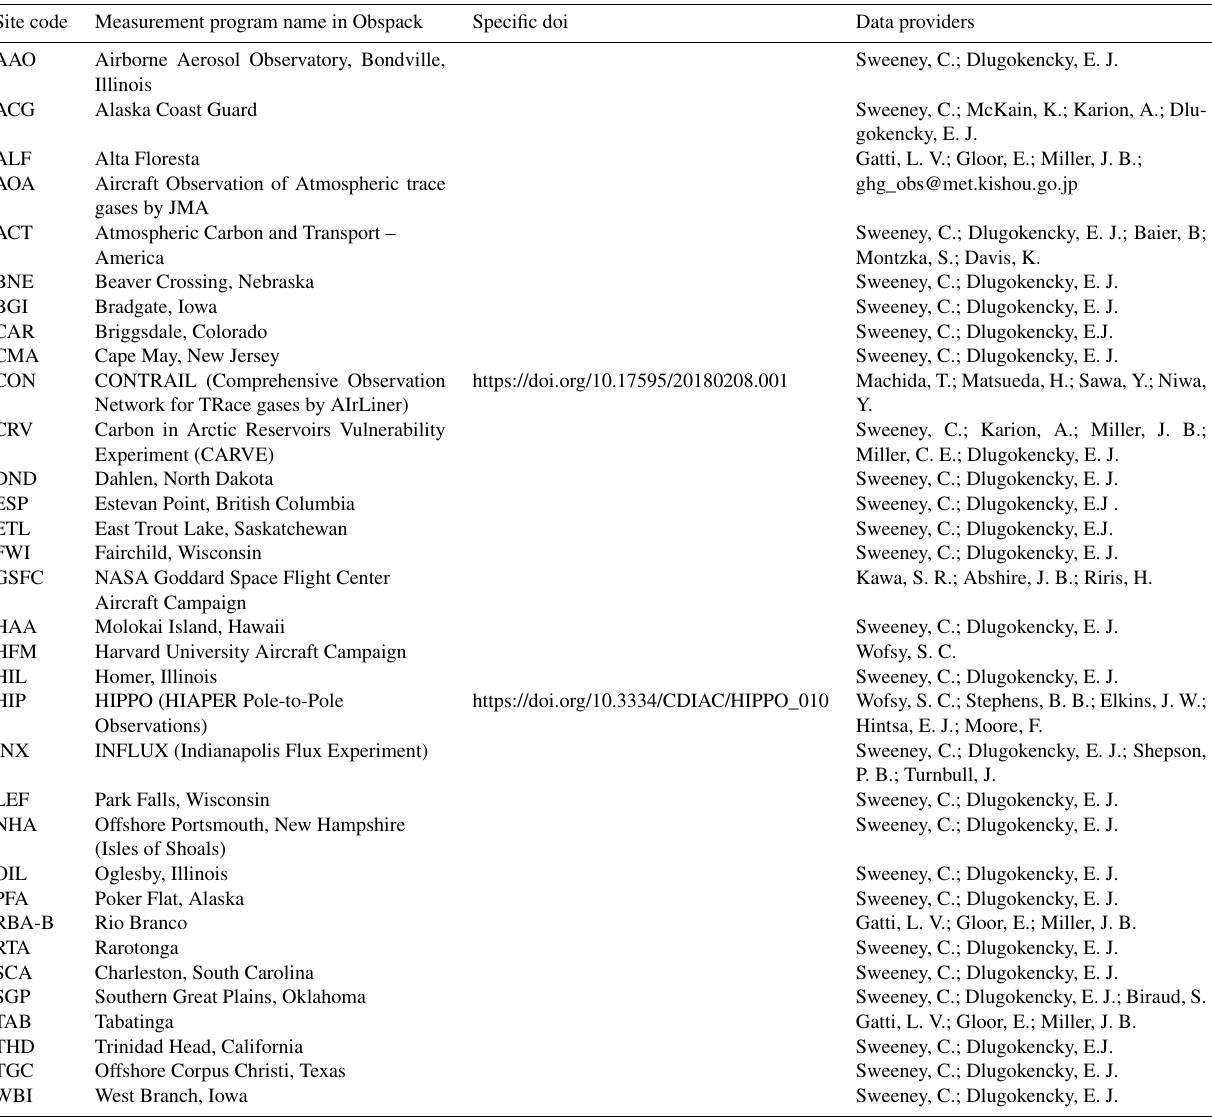
Table A6. Aircraft measurement programs archived by Cooperative Global Atmospheric Data Integration Project (CGADIP, 2020) that contribute to the evaluation of the atmospheric inversions (Fig.